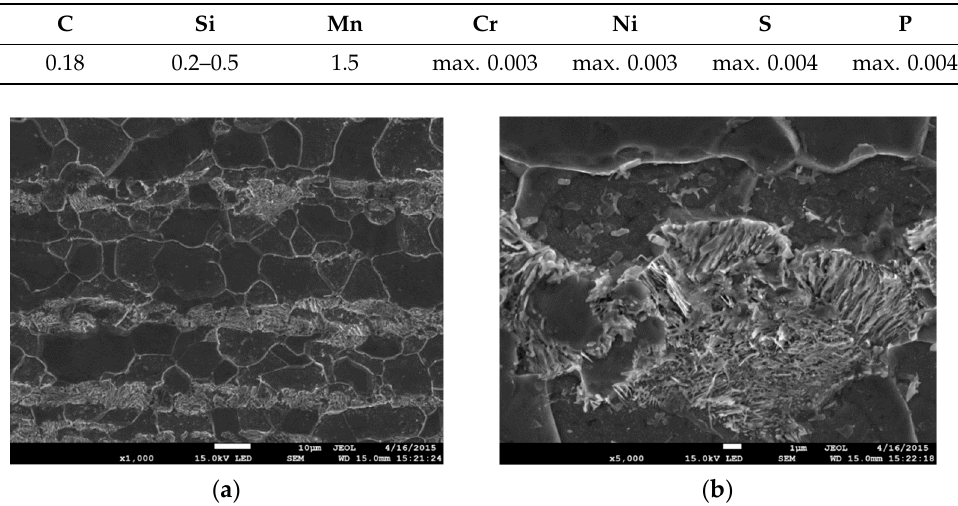
Table 1. Chemical composition of S355 steel (weight %).